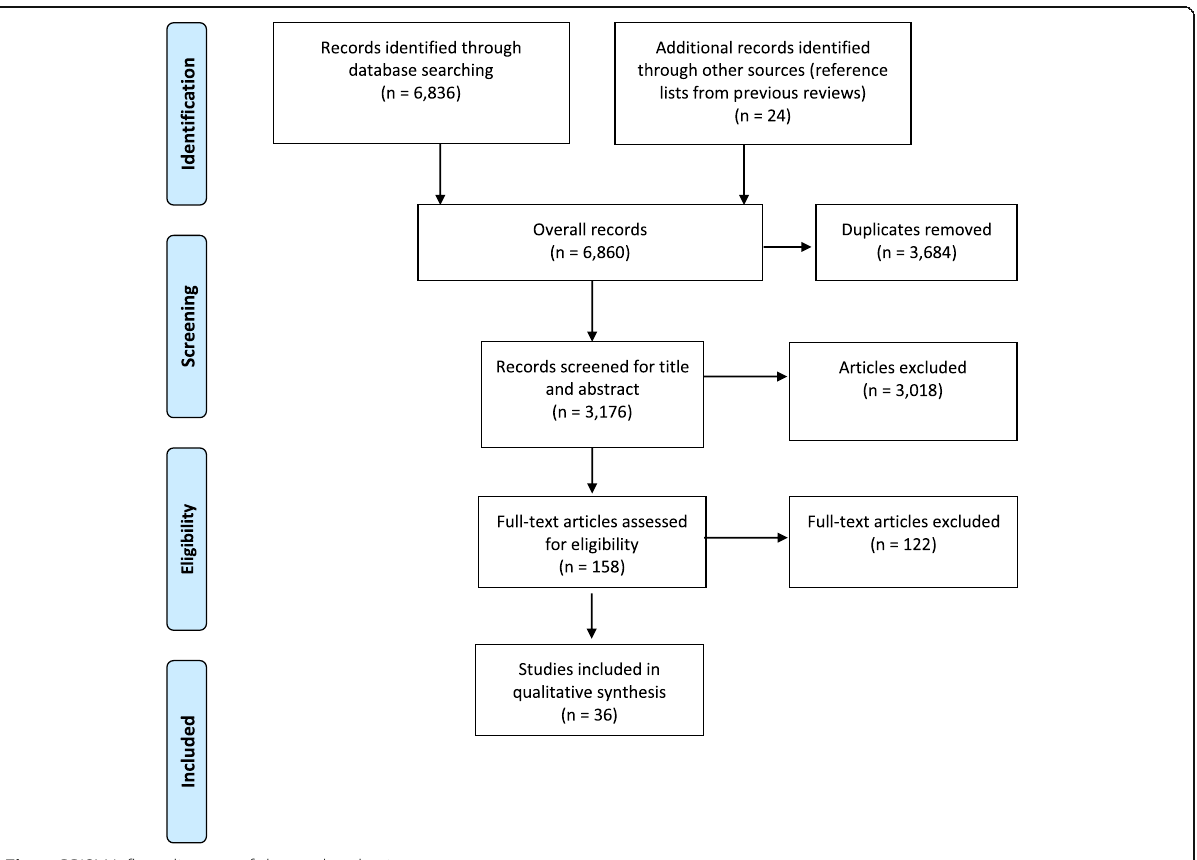
Fig. 1 PRISMA flow-diagram of the study selection